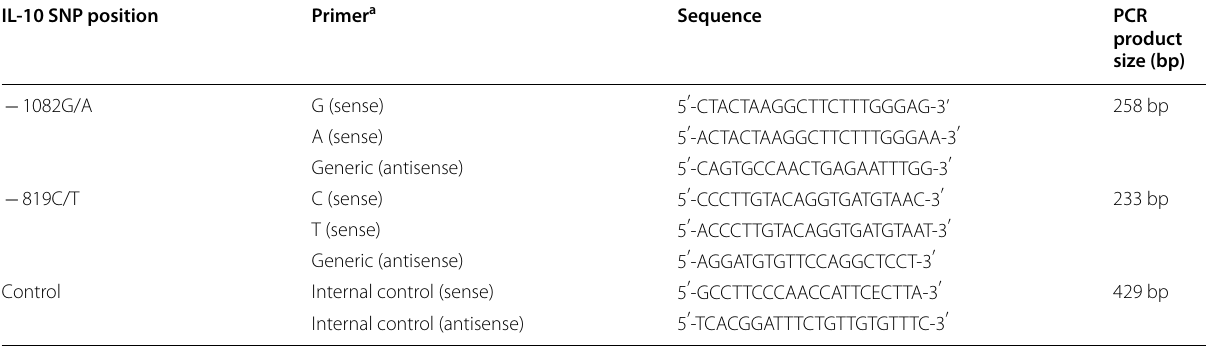
1082 G/A and 819 C/T) − −